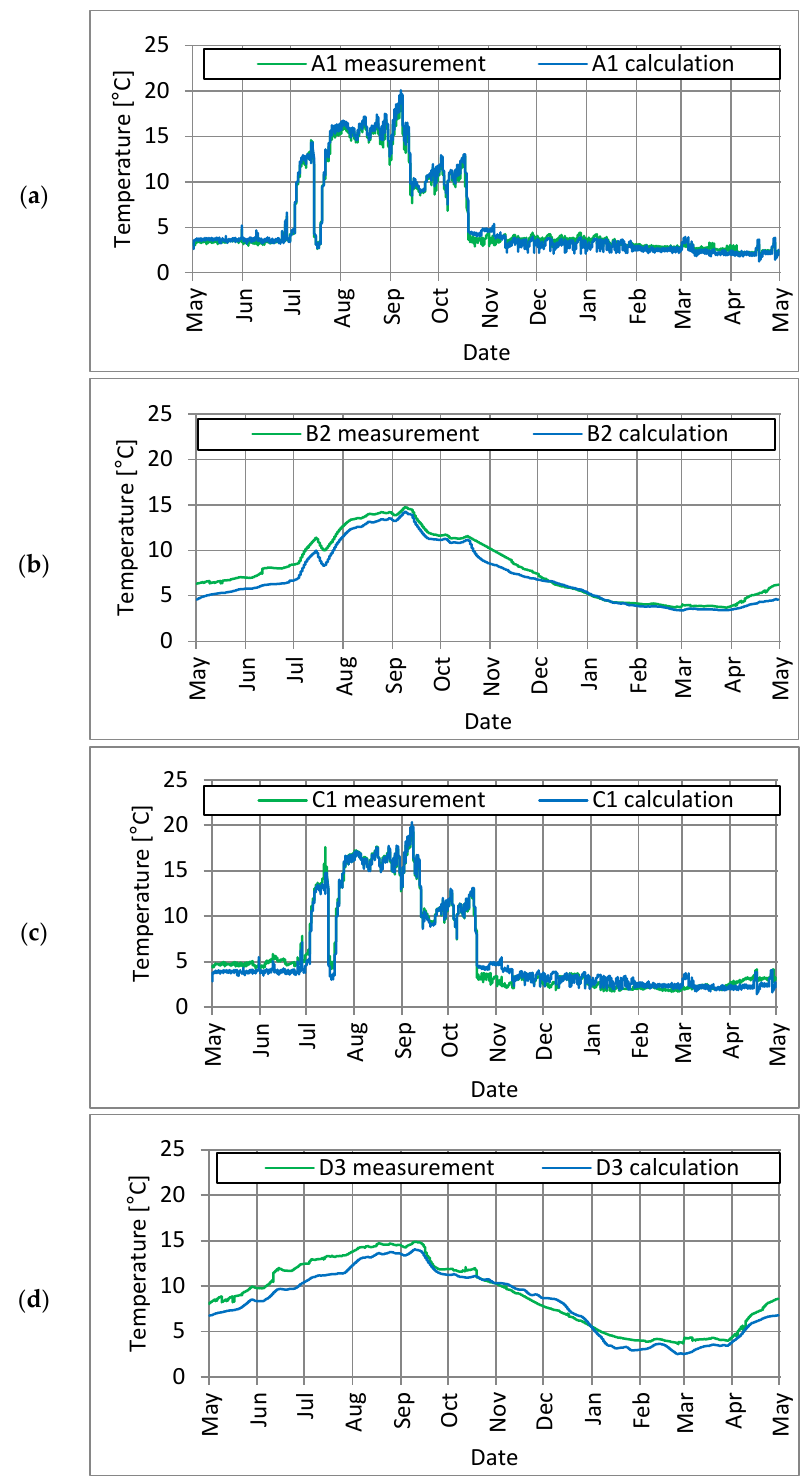
Figure 5. The course of the measured and calculated temperature of the floor and the ground for the selected measurement points: ( a ) point A1, ( b ) point B2, ( c ) point C1, ( d ) point D3.